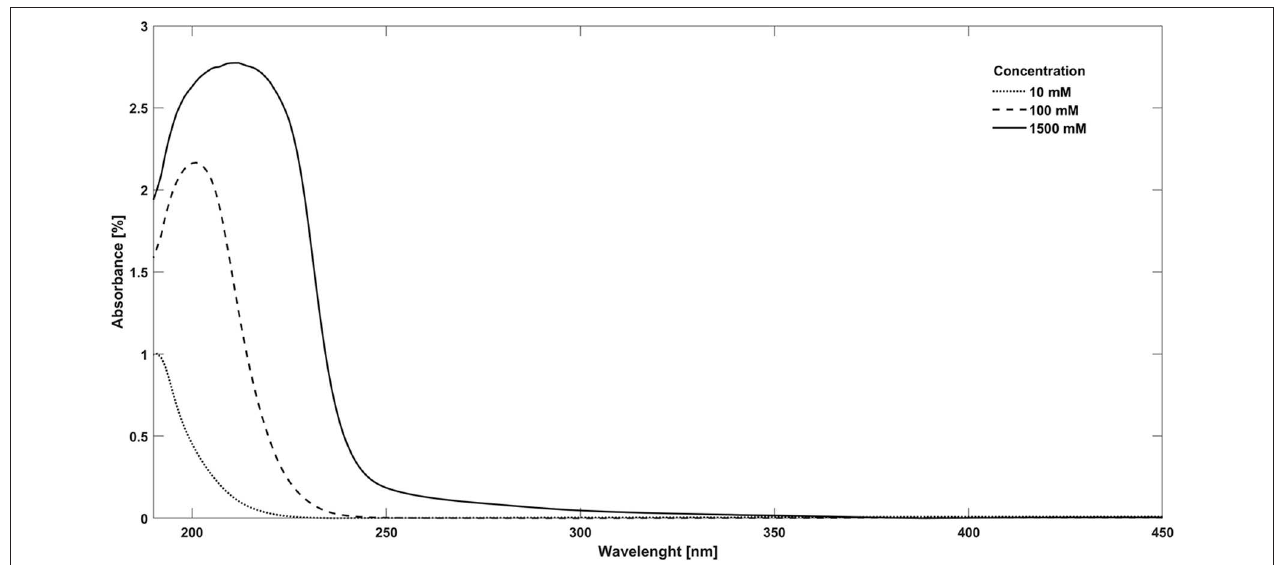
FIGURE 1 | Water–glycine adsorption UV spectra at various concentrations: dotted line, 10mM; dashed line, 100mM; and continuous line, 1,500mM.